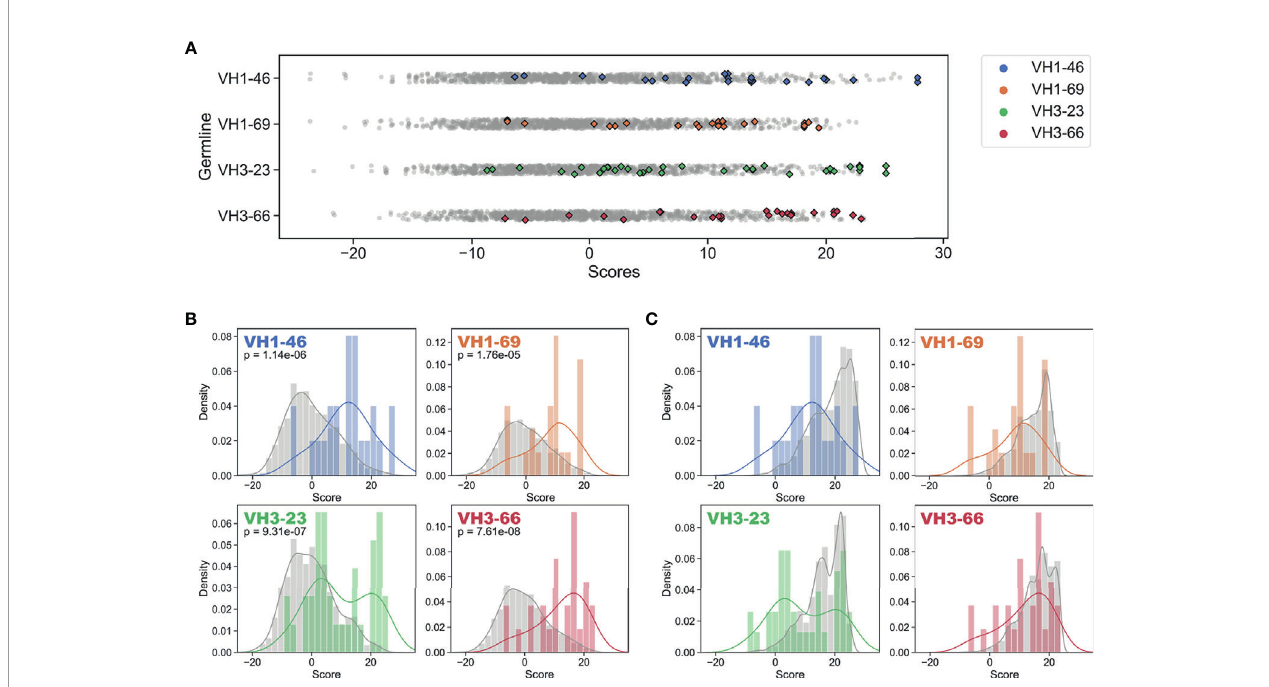
FIGURE 3 | Regulatory approved monoclonal antibodies contain framework mutations predicted from human antibody repertoires. Repertoire-based PSSM scores (gray) compared to FDA-approved FR mutation scores (colored) for each of four germline genes (Blue: V H 1-46, Orange: V H 1-69, Green: V H 3-23, Red: V H 3-66). Individual scores (A) and distributions with kernel density estimates (B, C) are shown for scores of the entire set of possible substitutions (B) and all FR mutation scores for a sample of 1,000 repertoire antibody sequences (C) . P-values are calculated using single-tailed Welch ’ s